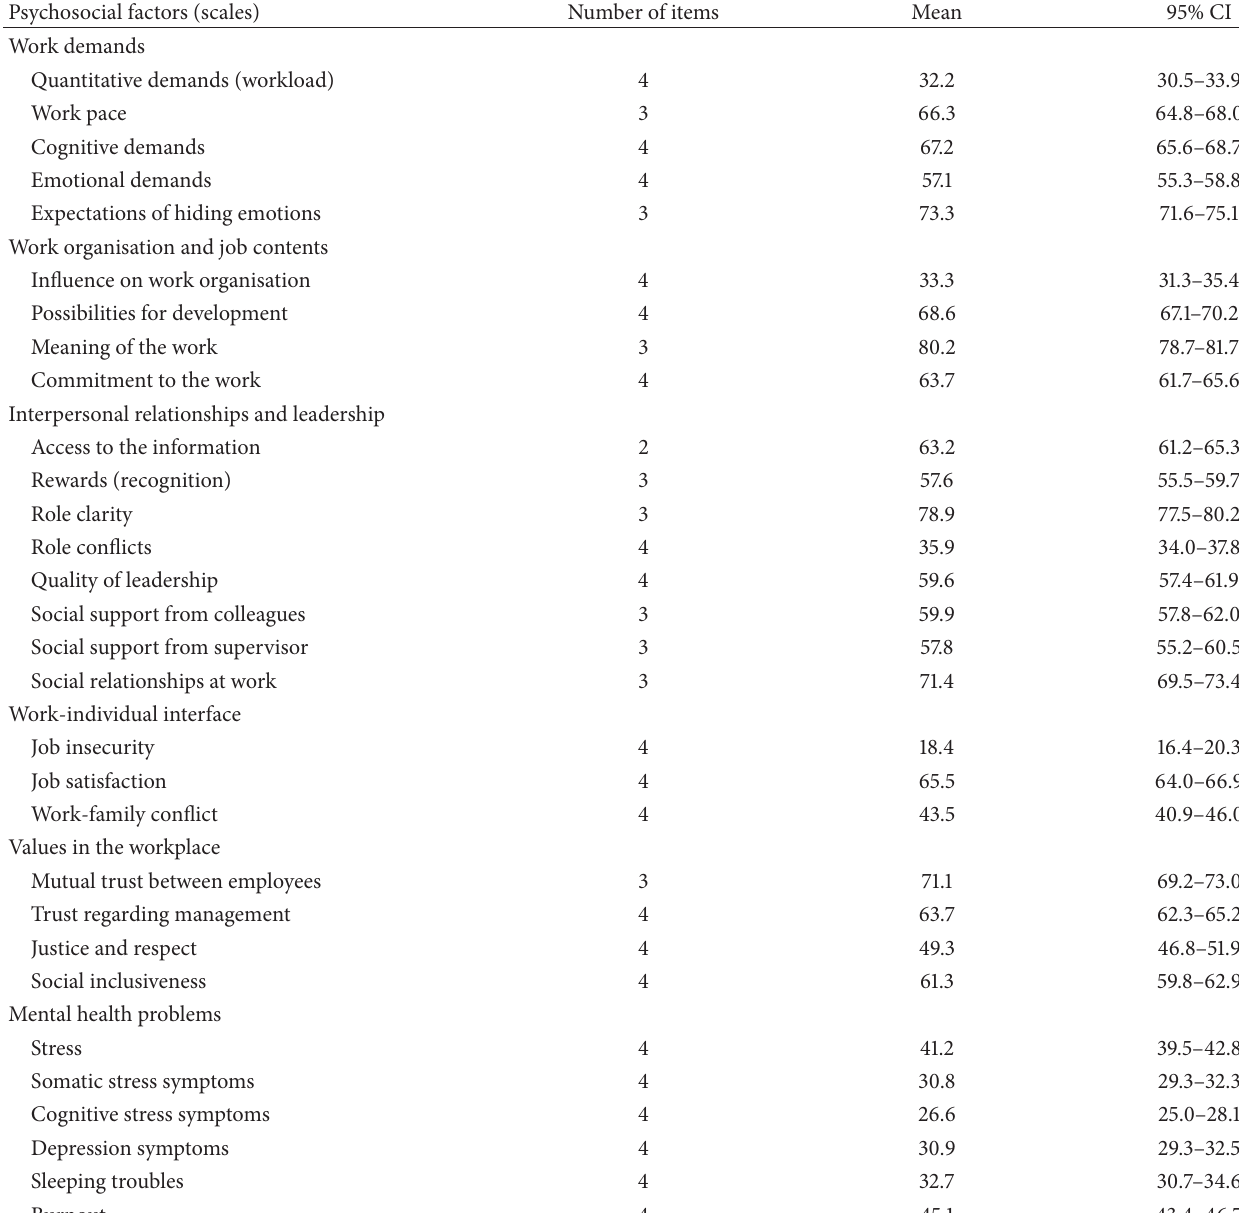
Table 2: Work-related psychosocial factors and mental health problems for 404